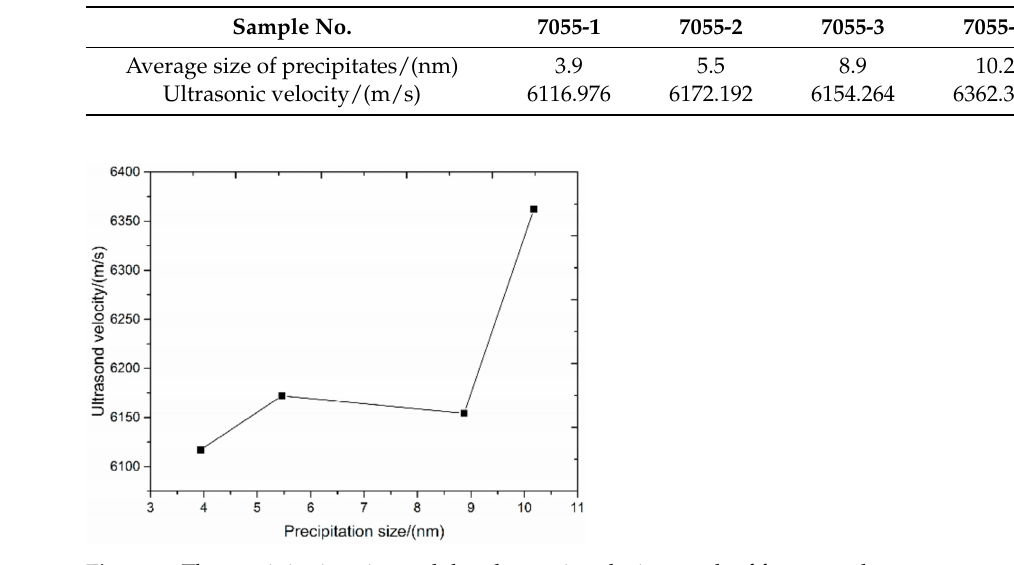
Figure 9. The precipitation size and the ultrasonic velocity graph of four